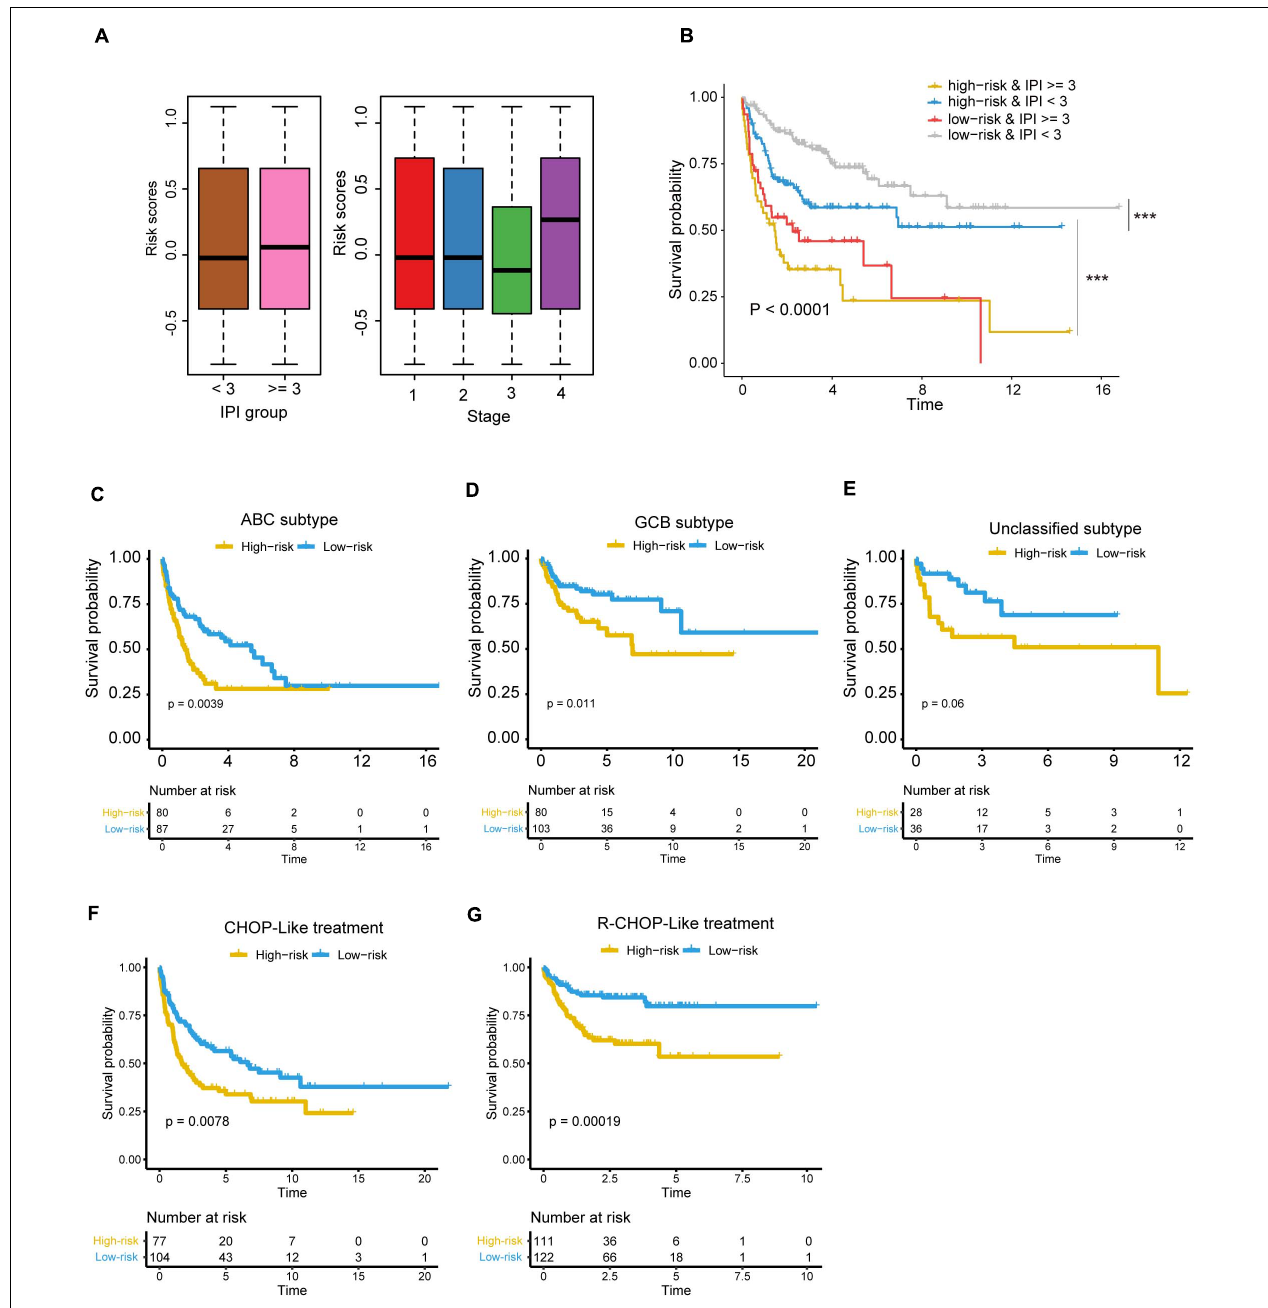
FIGURE 5 | The risk stratification based on the five prognostic genes is independent of clinical factors. (A) The risk scores in different IPI groups (left panel) and clinical stages (right panel). The boxes show the median and the interquartile range (IQR) of the risk scores grouped by the IPI scoring system and clinical stage in the validation dataset. There are no significant differences between those groups ( P > 0.05). (B) Kaplan–Meier survival curves show the overall survival of samples grouped by combining the IPI scoring system and the five-gene-based risk stratification. *** P < 0.0001. The differences of overall survival between the high-risk and low-risk groups in specific subtype or with specific chemotherapy regiment [ (C) ABC subtype; (D) GCB subtype; (E) unclassified subtype, (F) DLBCL treated with CHOP-Like regiment, (G) DLBCL treated with R-CHOP-Like